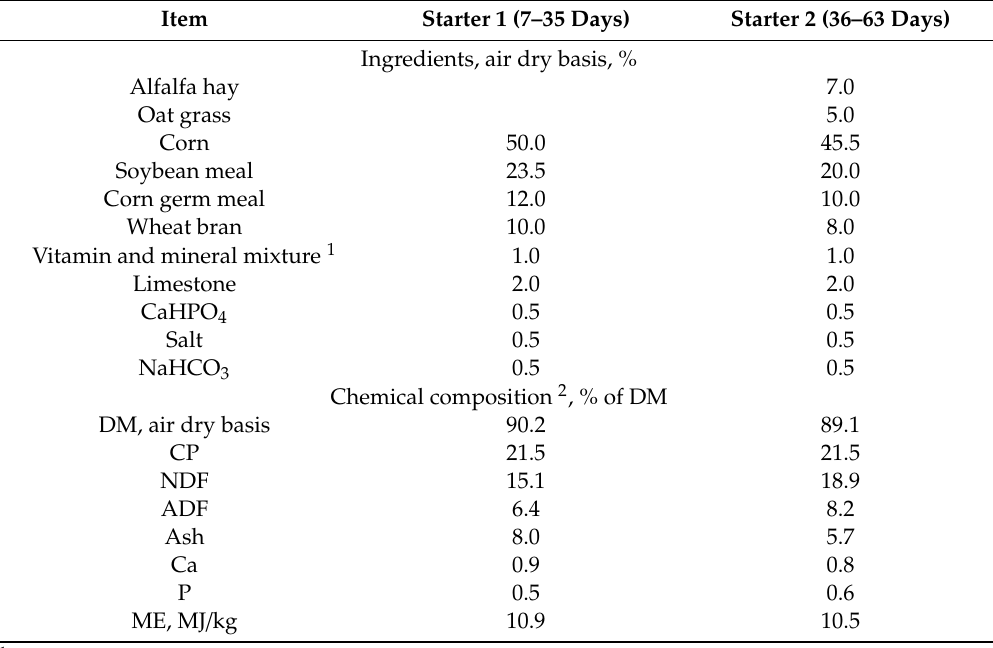
Table 1. Ingredients and chemical composition of the